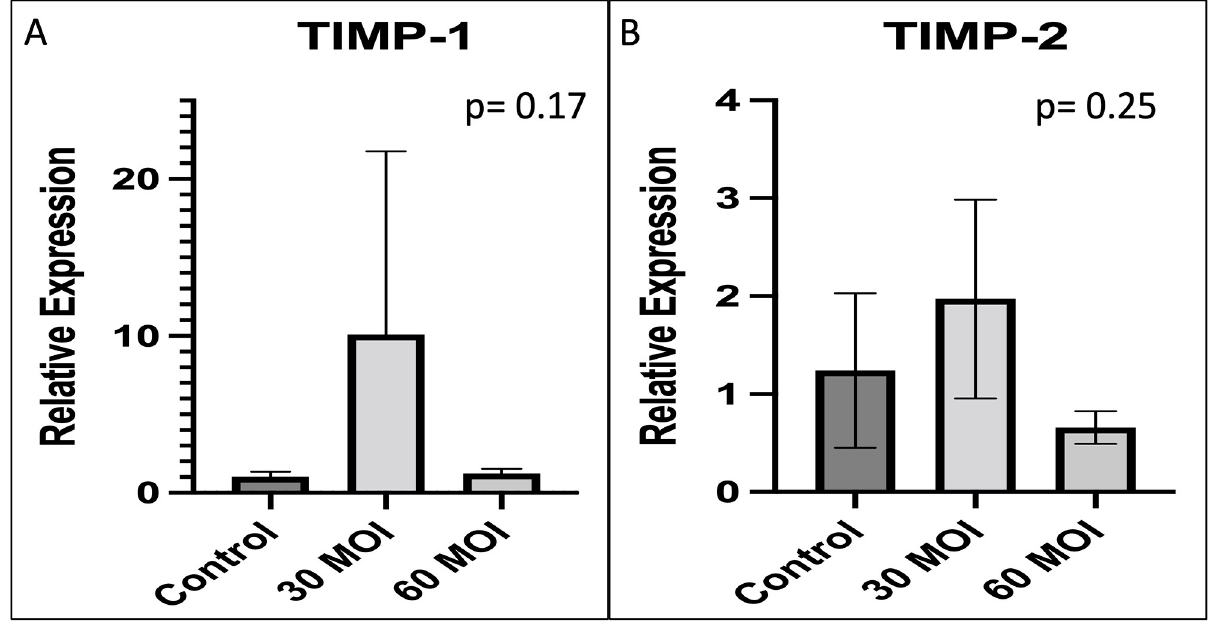
Fig 8. Comparison of pro-glycocalyx agents. A comparison of pro-glycocalyx agent expression as measured by real-time PCR demonstrating that there is no difference in A) TIMP-1 and B) TIMP-2 when H1N1 infected human umbilical vein endothelial cells are compared to control.